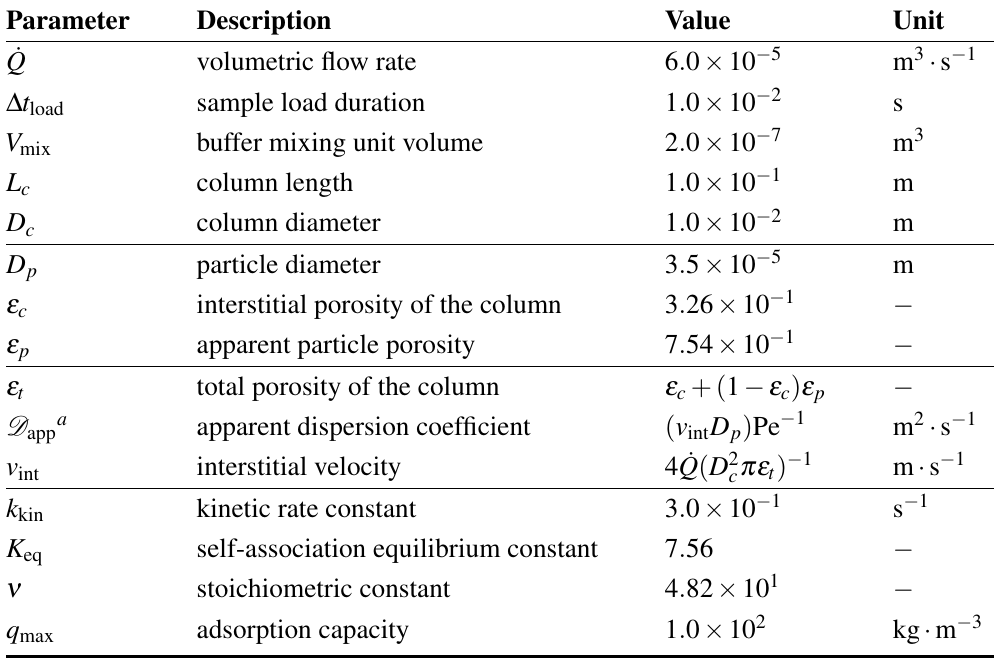
Table 1. HPLC system component design parameters and HIC column